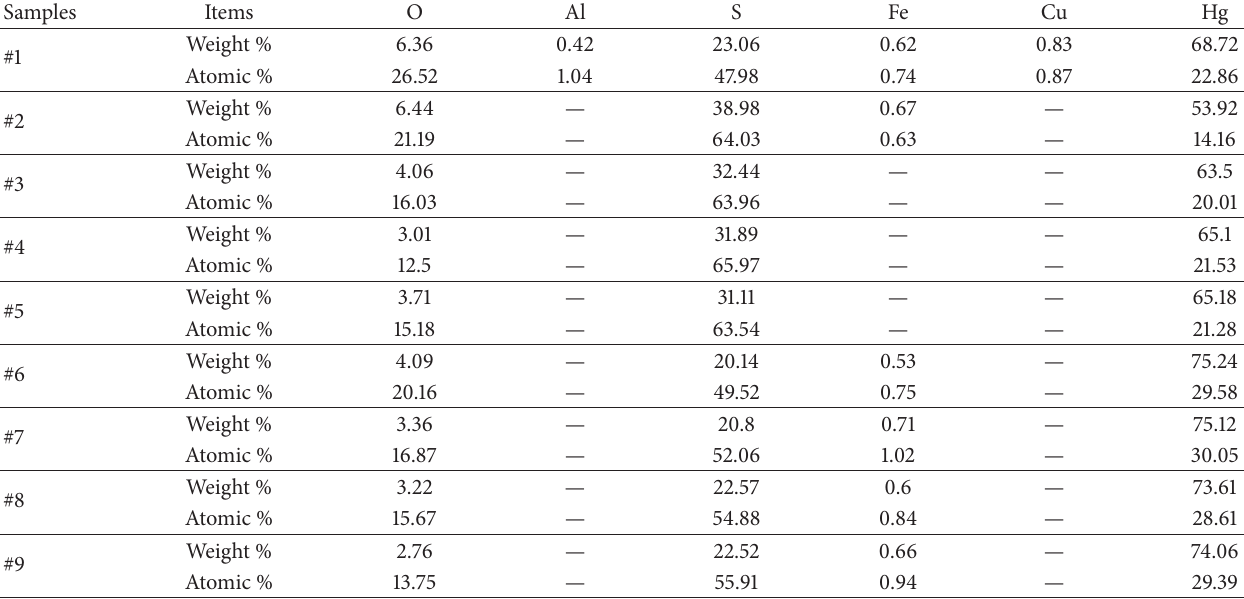
Table 2: Elemental contents in nine Zuotai samples by energy dispersive spectrometry of X-ray (EDX). Samples